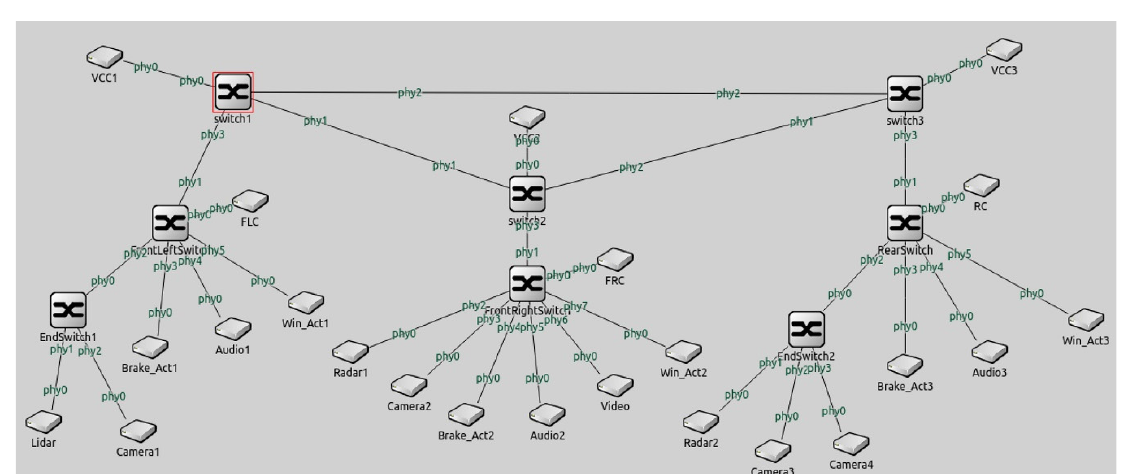
Table 5. Design table of traffic priority and redundancy.